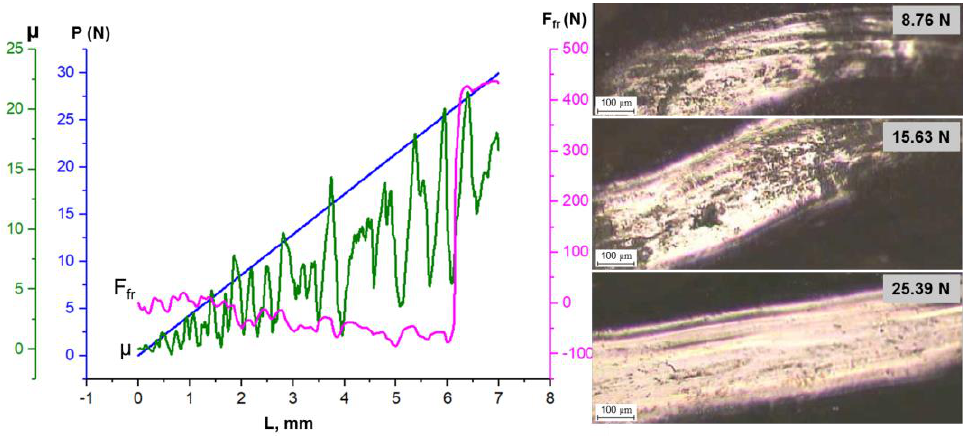
Figure 14. Measurement of the friction force F fr and the friction coefficient µ, with an increase in the load, applied to the indenter during the scratching of a five-layer coating.